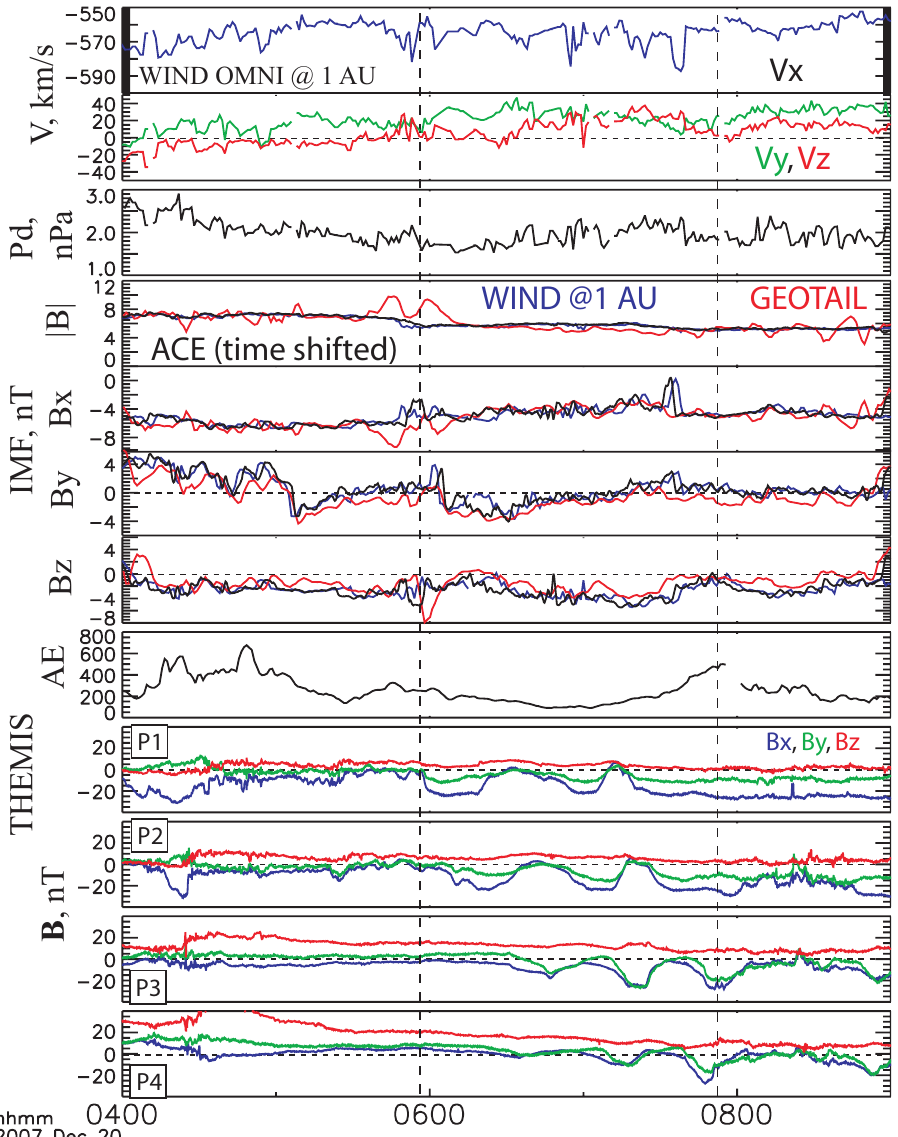
Fig. 1. Observations during 04:00–09:00UT on December 20, 2007. From top to bottom: the X-component of solar wind bulk velocity, Y and Z GSM components of the solar wind velocity, and solar wind dynamic pressure from the WIND satellite, the IMF strength, and GSM components of the IMF from WIND; THEMIS pseudo-AE index; magnetic field (GSM) from the four THEMIS probes (P1, P2, P3 and P4) versus